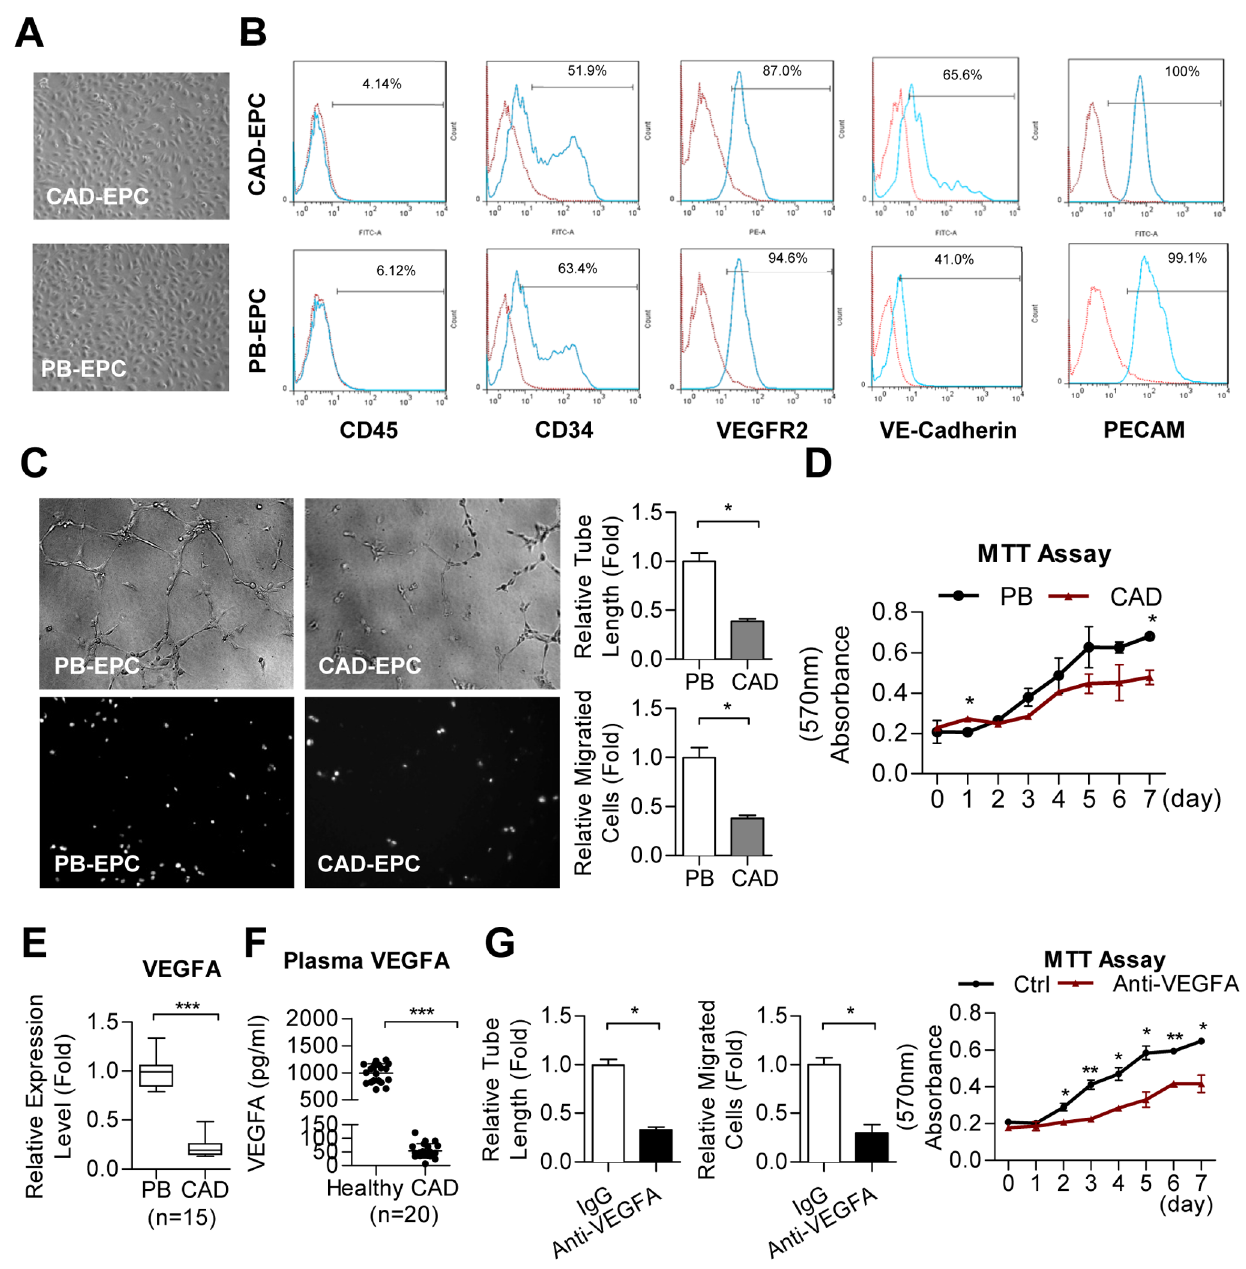
Figure 1. Reduced VEGF levels and angiogenic activities in EPCs from CAD patients. ( A ) Morphology of healthy and diseased EPCs. ( B ) Expression of indicated molecules in EPCs by flow cytometric analyses. ( C ) Different angiogenic abilities between healthy and diseased EPCs. EPCs from peripheral blood of healthy individuals (PB-EPCs) migrate faster and form better microvasculature structures in vitro than those from patients with CAD (CAD-EPCs). EPCs from different sources were subjected to Transwell cell migration assays or onto MatriGel for tube formation assays. Migrated cells were stained (representative pictures are shown, left lower panel) and counted (right panel, n=3). Tube lengths of formed microvascular structure were also measured (middle panel, n=3). *: p , 0.05 by Student’s T test. ( D ) Cell proliferation assays show PB-EPCs grow faster in vitro. Cultured EPCs were subjected into MTT assays for monitoring cell proliferation rate. *: p , 0.05 by Student’s T test. ( E ) Hierarchical VEGF mRNA expression levels in CAD-EPC and healthy PB-EPC showed by RT-qPCR. Mean gene expression levels of EPC genes were compared to the average CT values of GAPDH and beta-actin controls. Results are expressed as mean 6 standard deviation. ***: p , 0.001 by Mann-Whitney U test. ( F ) Reduced serum VEGF protein levels in CAD patients determined by ELISA assays. ***: p , 0.001 by Mann-Whitney U test. ( G ) Treating PB-EPCs with the Avastin anti-VEGF mAb suppresses in vitro microtubular formation, cell migration, and cell proliferation activities. *: p , 0.05, **: p , 0.01 by Student’s T test. doi:10.1371/journal.pone.0098070.g001 the plasma of CAD patients were lower than those in healthy culture medium of PB-EPCs. Cell motility, microvasculature controls (Fig. 1F). The critical function of VEGF on EPC activities formation ability, and cell proliferation activity of treated EPCs were all reduced significantly (Fig. 1G). was confirmed by adding the anti-VEGF mAb (Avavstin) into